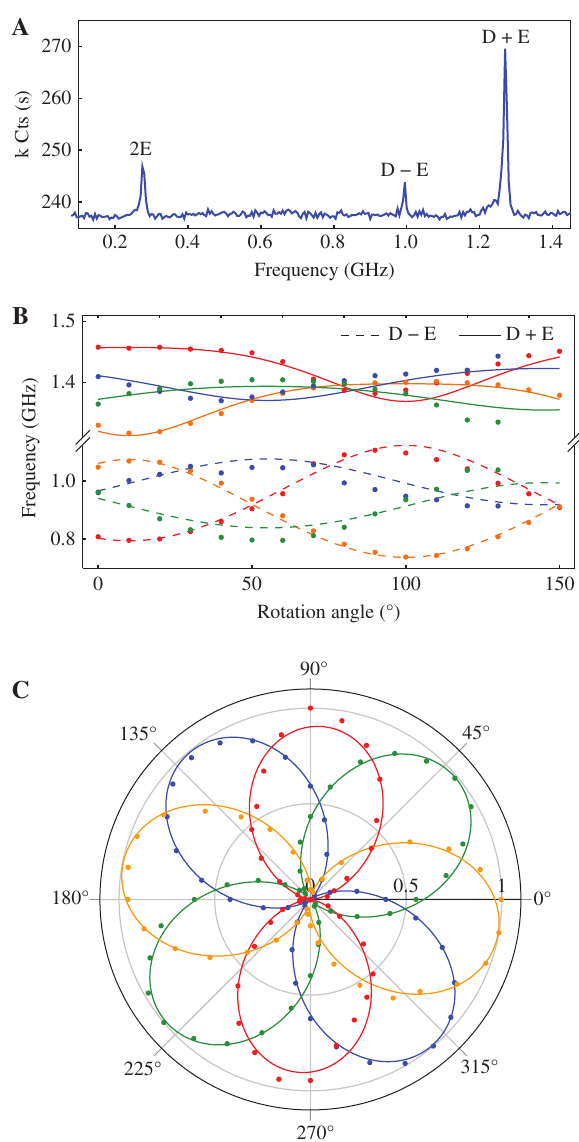
Figure 3: ODMR and optical polarization studies of the ST1 center. (A) ODMR spectrum of ST1 at zero magnetic field. (B) The response of the ODMR frequencies when a B = 120 Gauss magnetic field is rotated in the [001] crystal plane. The solid lines represent a fit using equation (1). (C) Plot of the polarization-dependent fluorescence of the ST1 centers. It shows four linear polarization states separated by 45 °